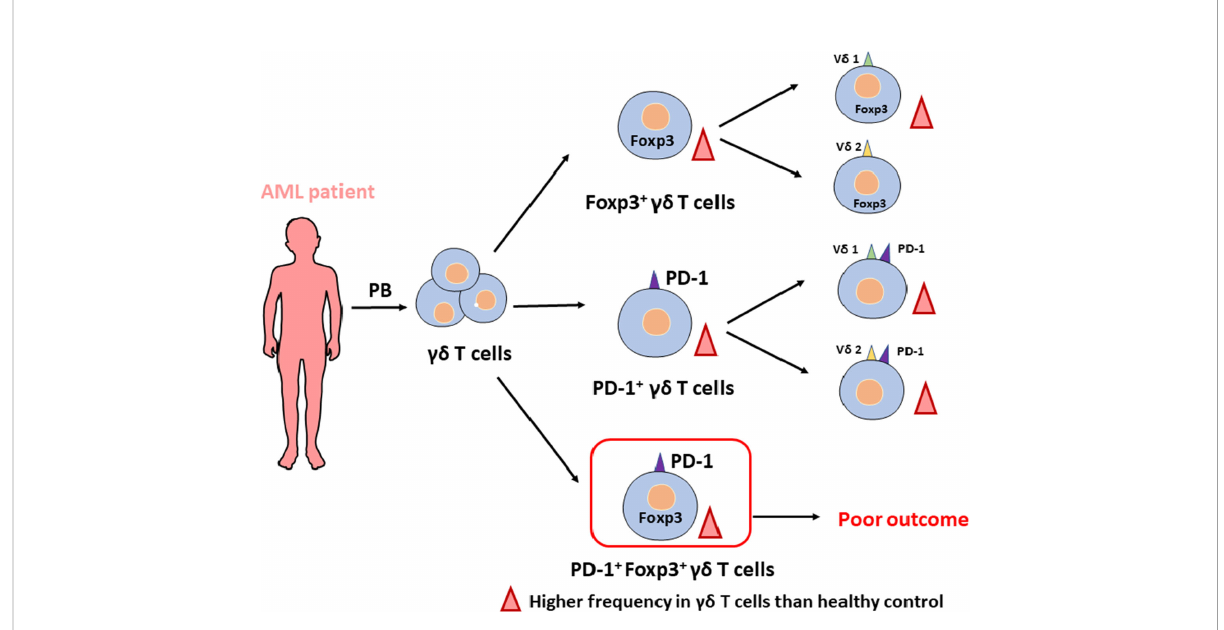
FIGURE 5 Overview of alterations in gd T cell subsets in patients with